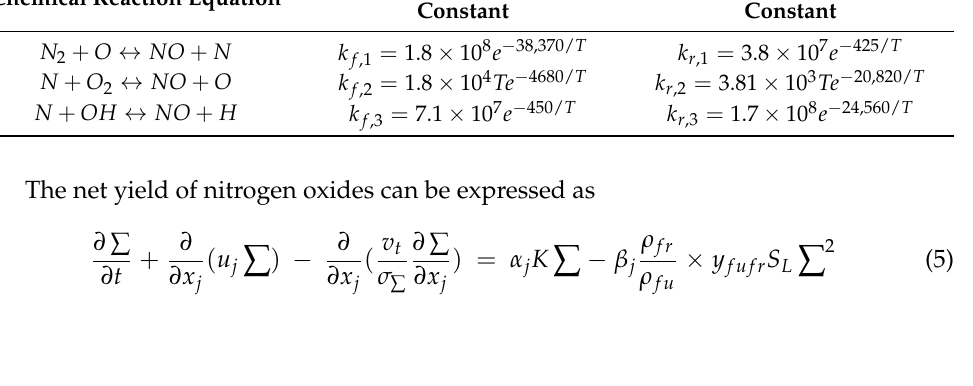
Table 1. Mechanism of thermal nitrogen oxides. Chemical Reaction